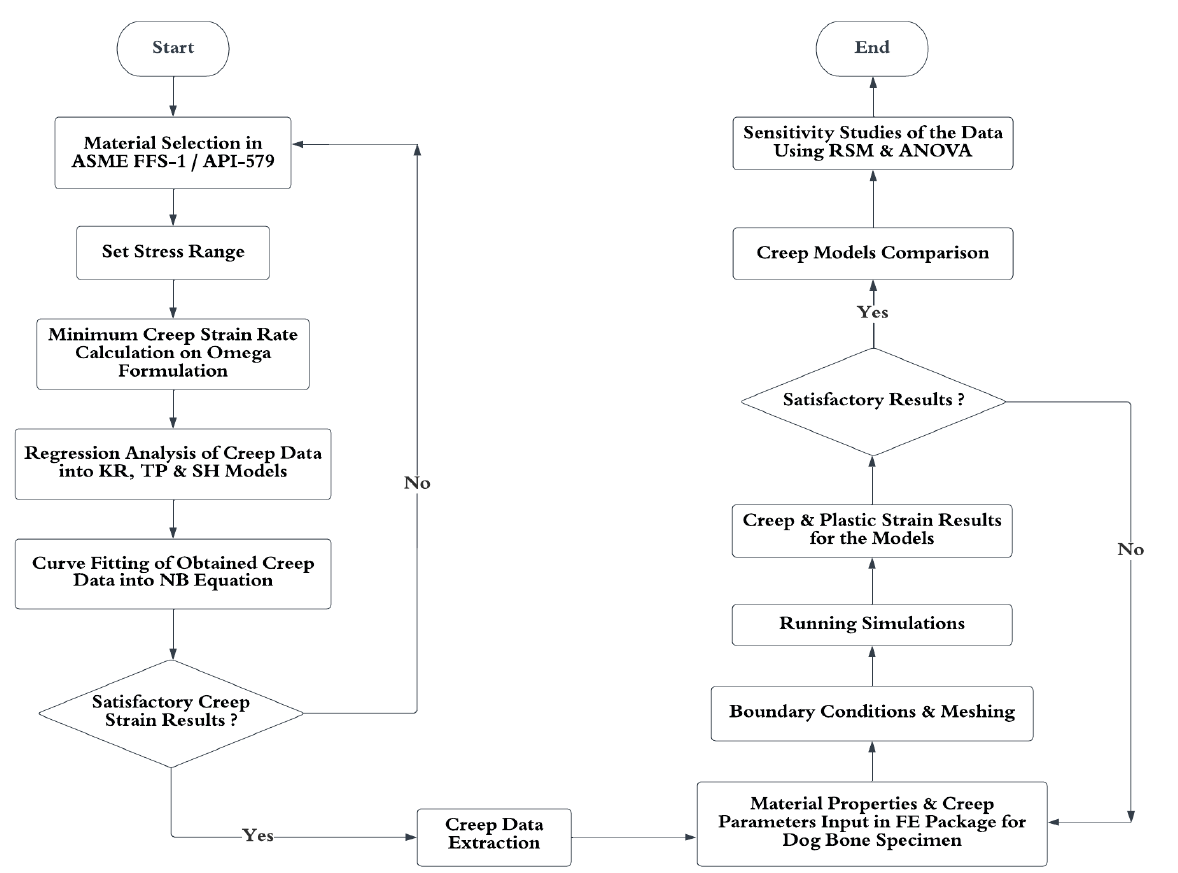
Figure 1. The overall methodology flowchart for acquiring creep data for the FE dog-bone specimen using the Omega–Norton–Bailey regression model [22].